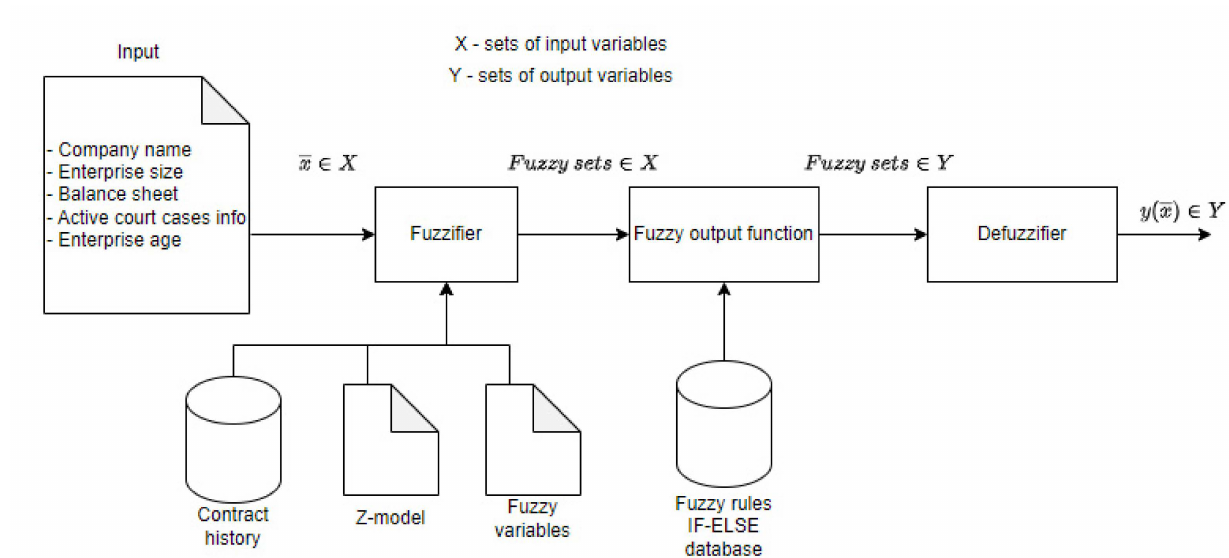
Figure 2. Main diagram of the fuzzy logic system for determining risk